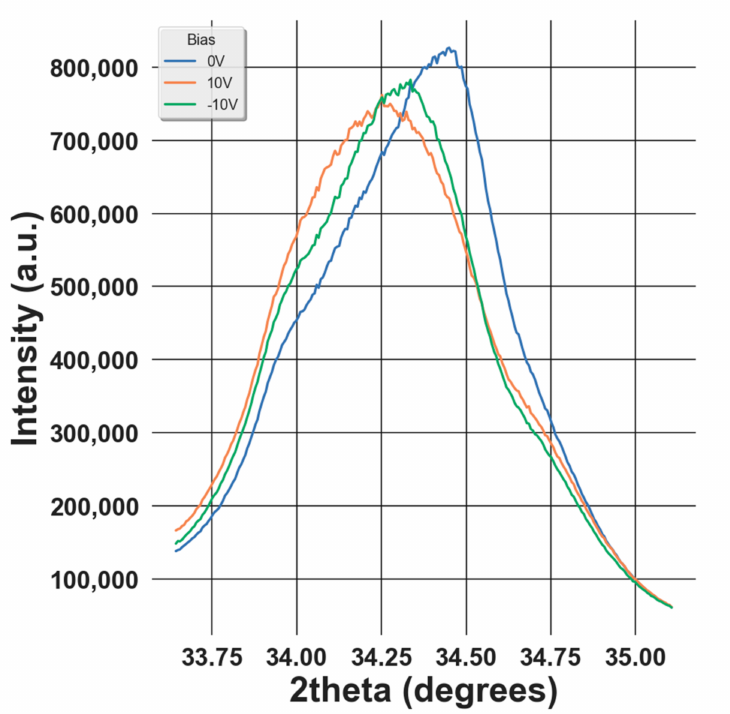
Figure 4. Variation XRD diagram as a function of the applied